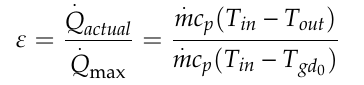
Figure 12. Thermal effectiveness versus normalized borehole length. 8. Conclusions The present study investigated relative changes in the thermal performance of double U-tube BHEs triggered by alterations in circuit arrangements, as well as the shank spacing and the borehole length by means of a series of 3D finite element simulations. The numerical model was validated against the analytical model based on the line-source method. In addition, the results obtained by numerical simulations were compared with those obtained through correlations deduced by linear regressions of a dimensionless coefficient. Three configurations for parallel arrangement of U-tubes